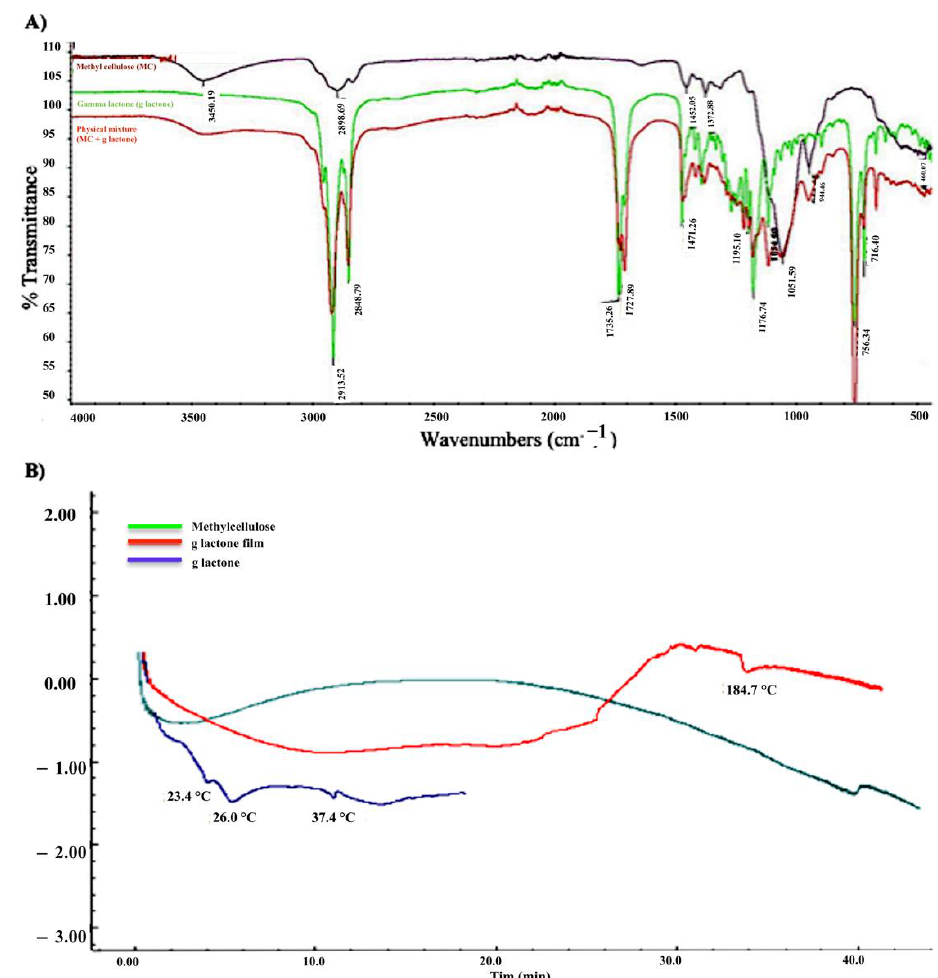
Figure 3. ( A ) FTIR spectra of γ -lactone (g lactone), methyl cellulose (MC), and γ -lactone in physical mixture with MC. The FTIR showed the typical peaks of γ -lactone without any foreign peaks due formulation. ( B ) Differential scanning calorimetry (DSC) for γ -lactone, MC, and γ -lactone in physical mixture with MC. Crosslinking of MC was detected forming plastic like film.